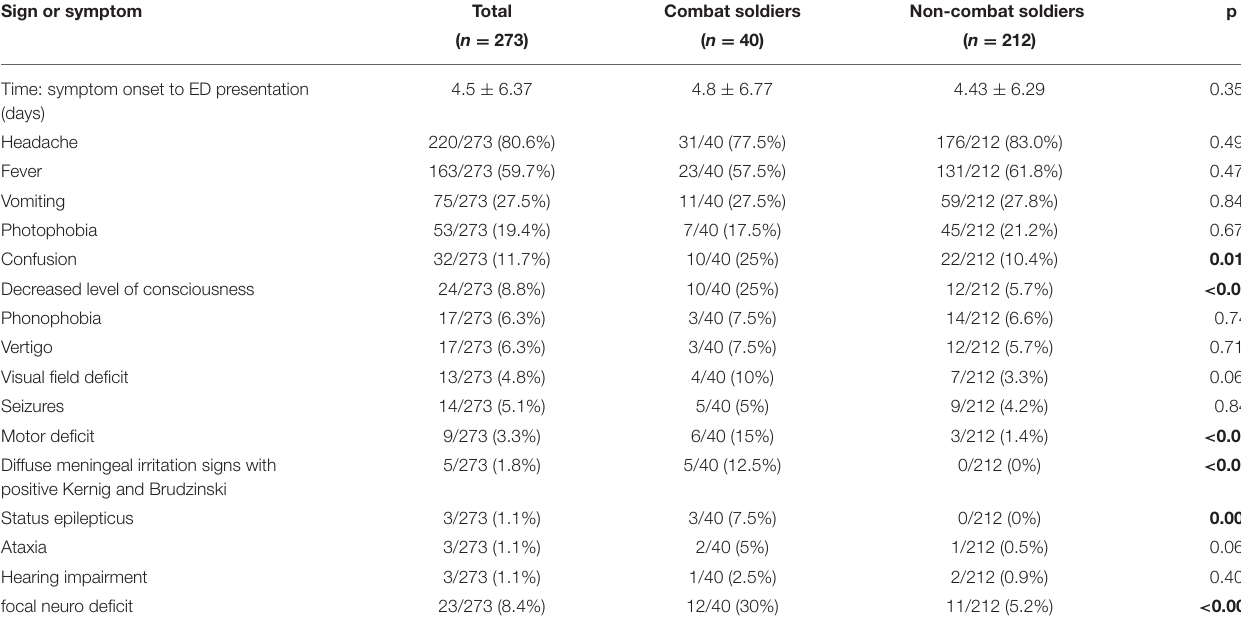
TABLE 1 | Clinical presentation upon arrival at the Emergency Department